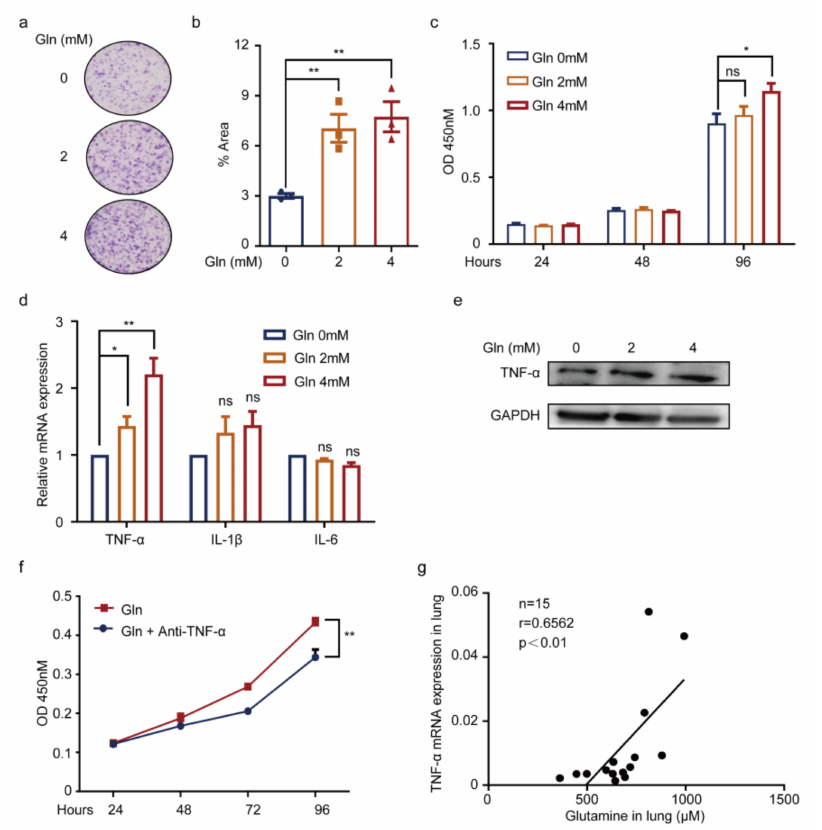
Figure 5. Glutamine contributes to pneumonia by promoting TNF- α expression of WI38 cells. ( a , b ) Images ( a ) and quantification ( b ) of plate clone of WI38 cells cultured in DMEM media with exogenous glutamine supplement (0 mM, 2 mM, 4 mM) (mean ± SEM, n = 3 for each